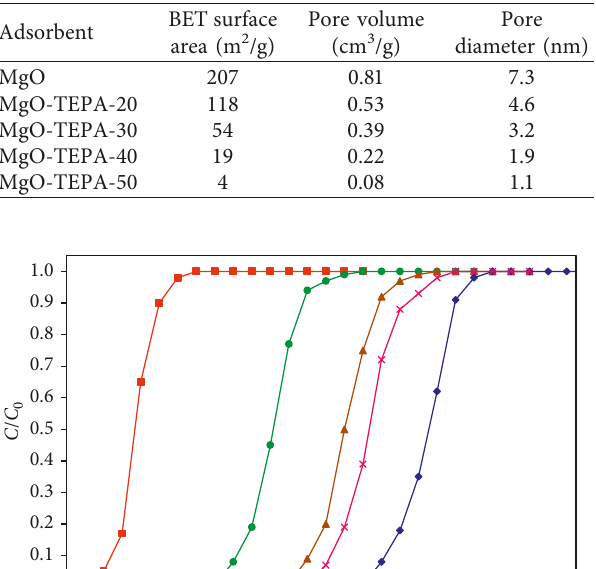
Table 1: Surface area, pore volume, and average pore diameter of MgO-TEPA- x .